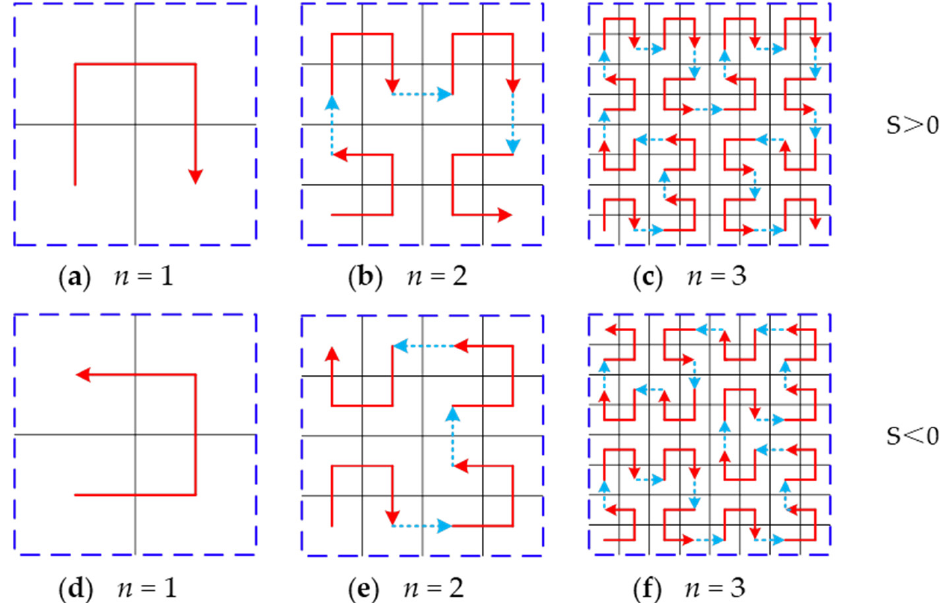
Figure 3. One to three orders of Hilbert curves with movement direction, ( a , d ) first-order Hilbert curve, ( b , e ) second-order Hilbert curve, ( c , f ) third-order Hilbert curve, the blue dash-dotted line denotes the magnified square, and the red arrow denotes the connecting order of grid center.